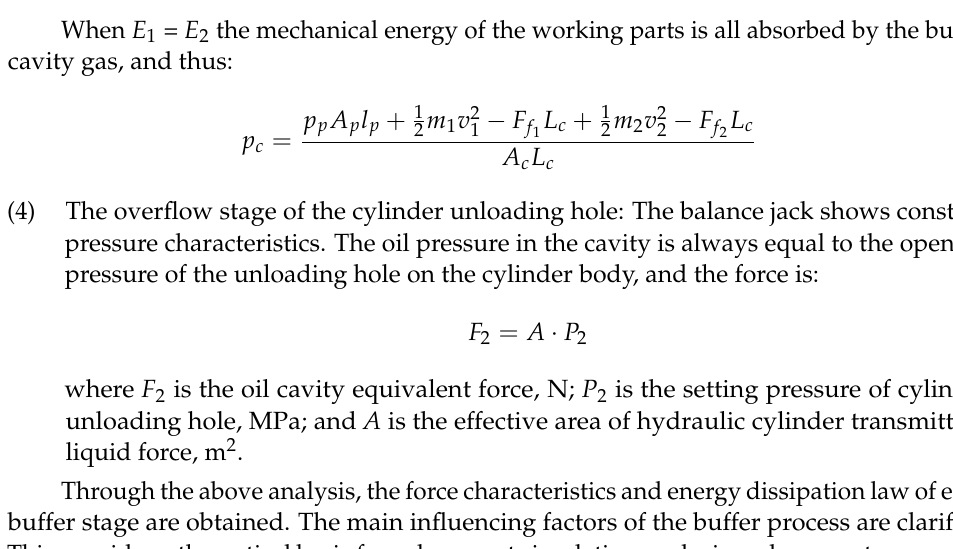
Figure 3. Schematic diagram of buffer process of multi-adaptive response balance